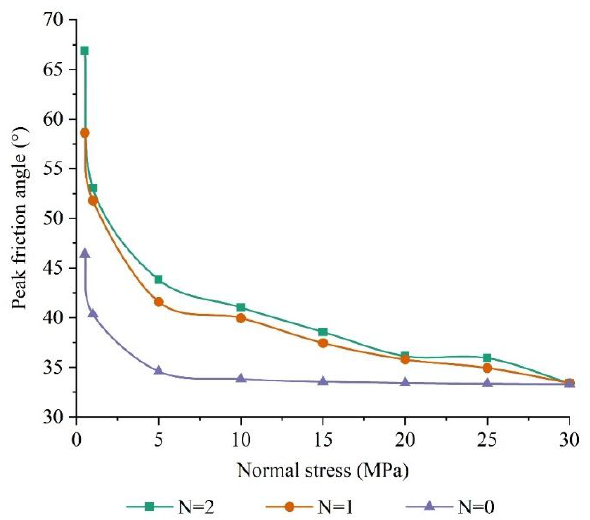
Figure 13: Relationship between the peak friction angle and normal stress of rock joint with different saw-tooth numbers